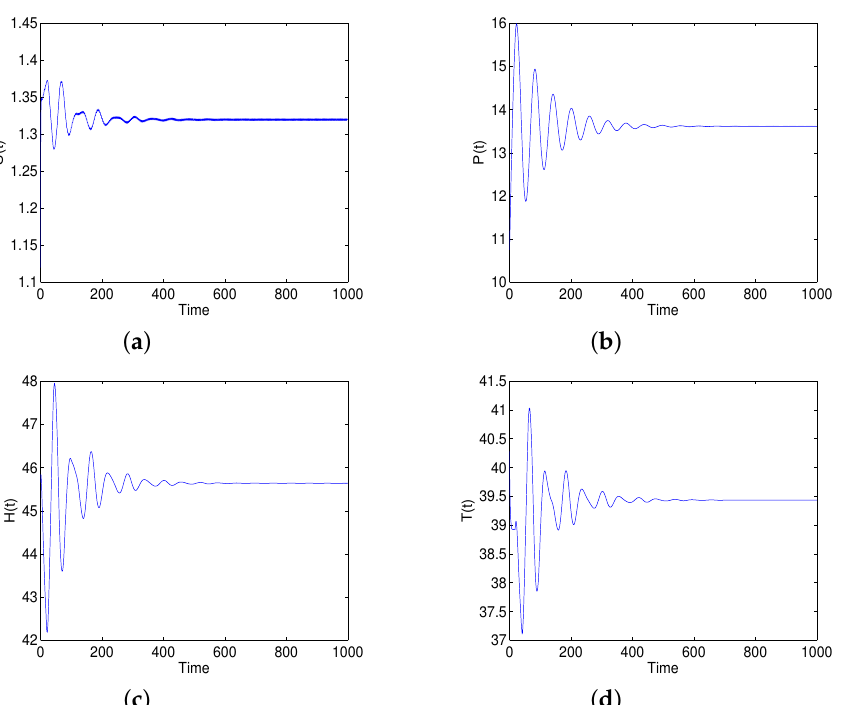
Figure 3. The time plot of ( a ) susceptible population, ( b ) psychological addicts, ( c ) physiological addicts and ( d ) drug-users in treatment for τ 2 = 18.6934 < τ 20 = 20.8839 with A = 2, d = 0.02, β 1 = 0.016, β 2 = 0.028, π = 0.03, γ = 0.095, θ = 0.5 and σ = 0.21.